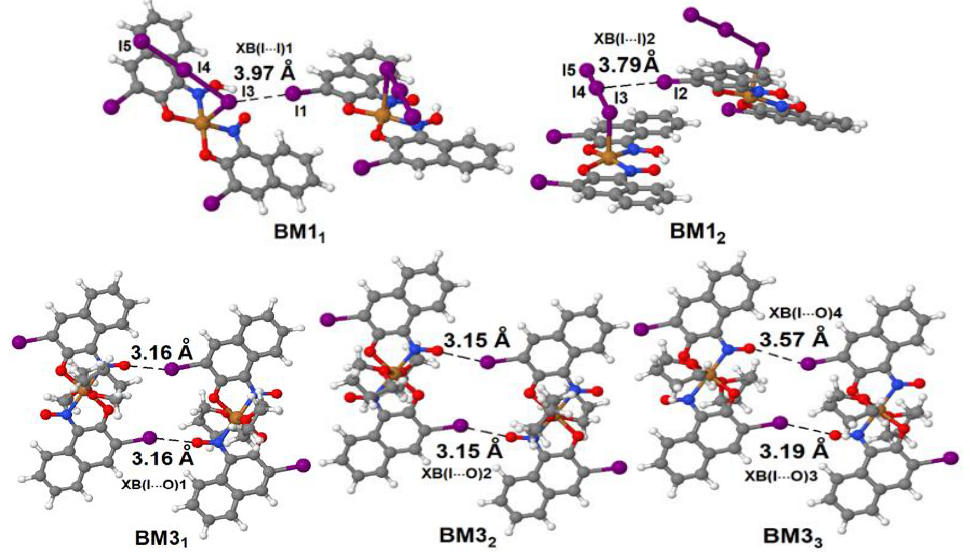
Figure 5. Computational models.